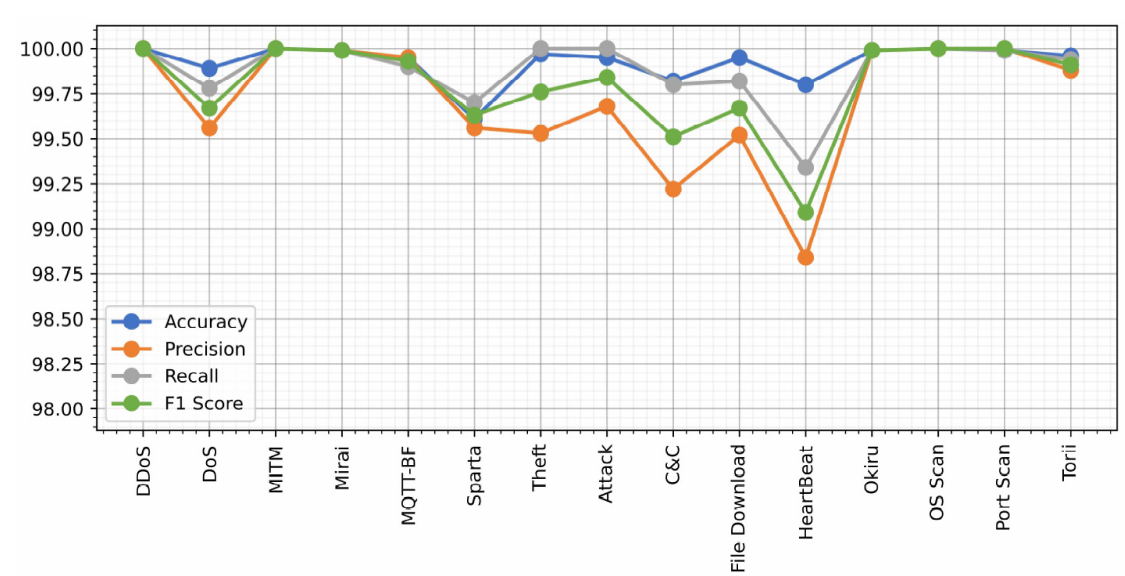
Figure 3. Performance metrics binary CNNGRU